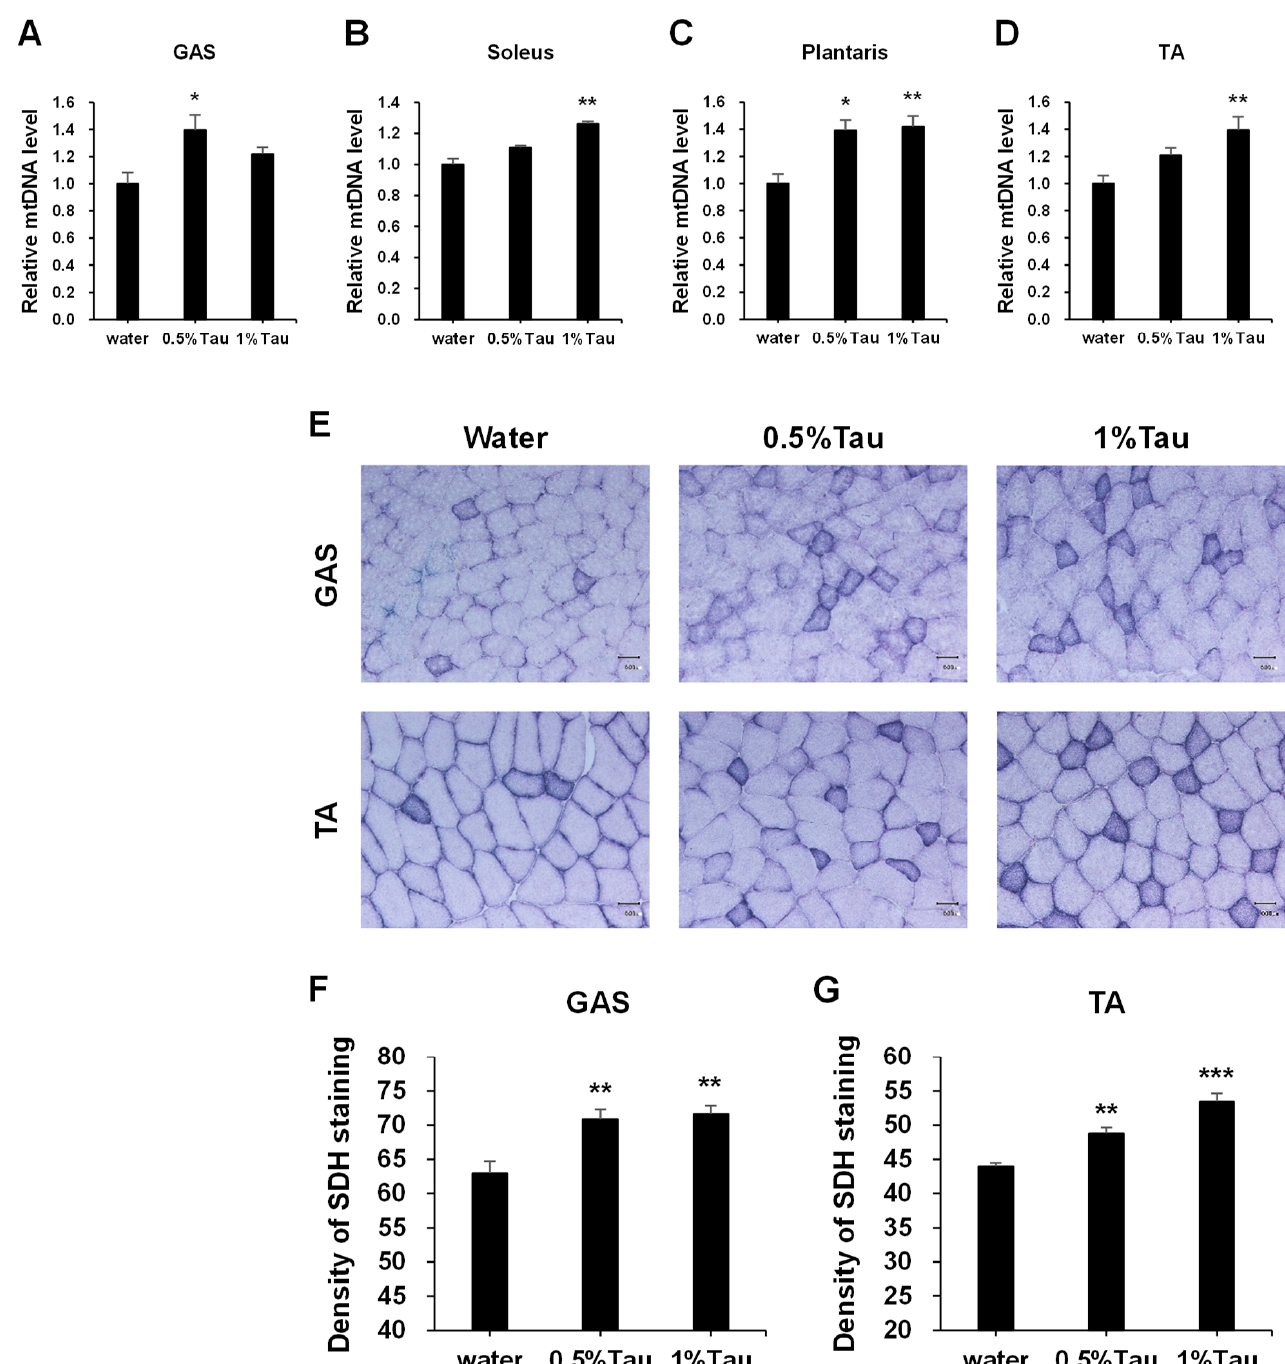
Figure 4. Effects of short-term taurine supplementation on the mitochondrial DNA (mtDNA) content ( A – D ) in the GAS, soleus, plantaris, and TA muscles, and SDH staining ( E ) and ImageJ (Ver. 1.52p) analysis of SDH staining ( F , G ) in the GAS and TA muscles of rats in the water, 0.5% taurine, and 1% taurine groups. Skeletal muscles of SD rats at 14 weeks of age were collected 4 h after administration on the 10th day. The administration levels of taurine are indicated in Figure 1. Scale bar, 500 µ m. Values shown represent the mean ± SE (n = 3–6). * p < 0.05, ** p < 0.01, *** p < 0.001, statistically significant vs. the values of water group. Results were analyzed using Dunnett’s